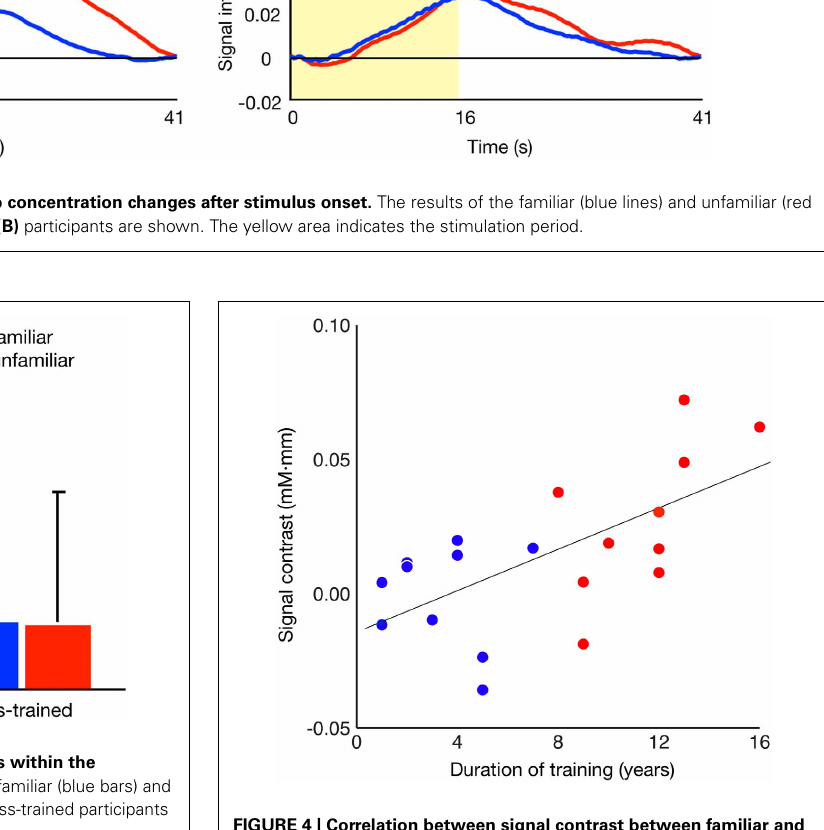
unfamiliar conditions and duration of piano training. Red and blue dots represent the results of well-trained and less-trained participants,